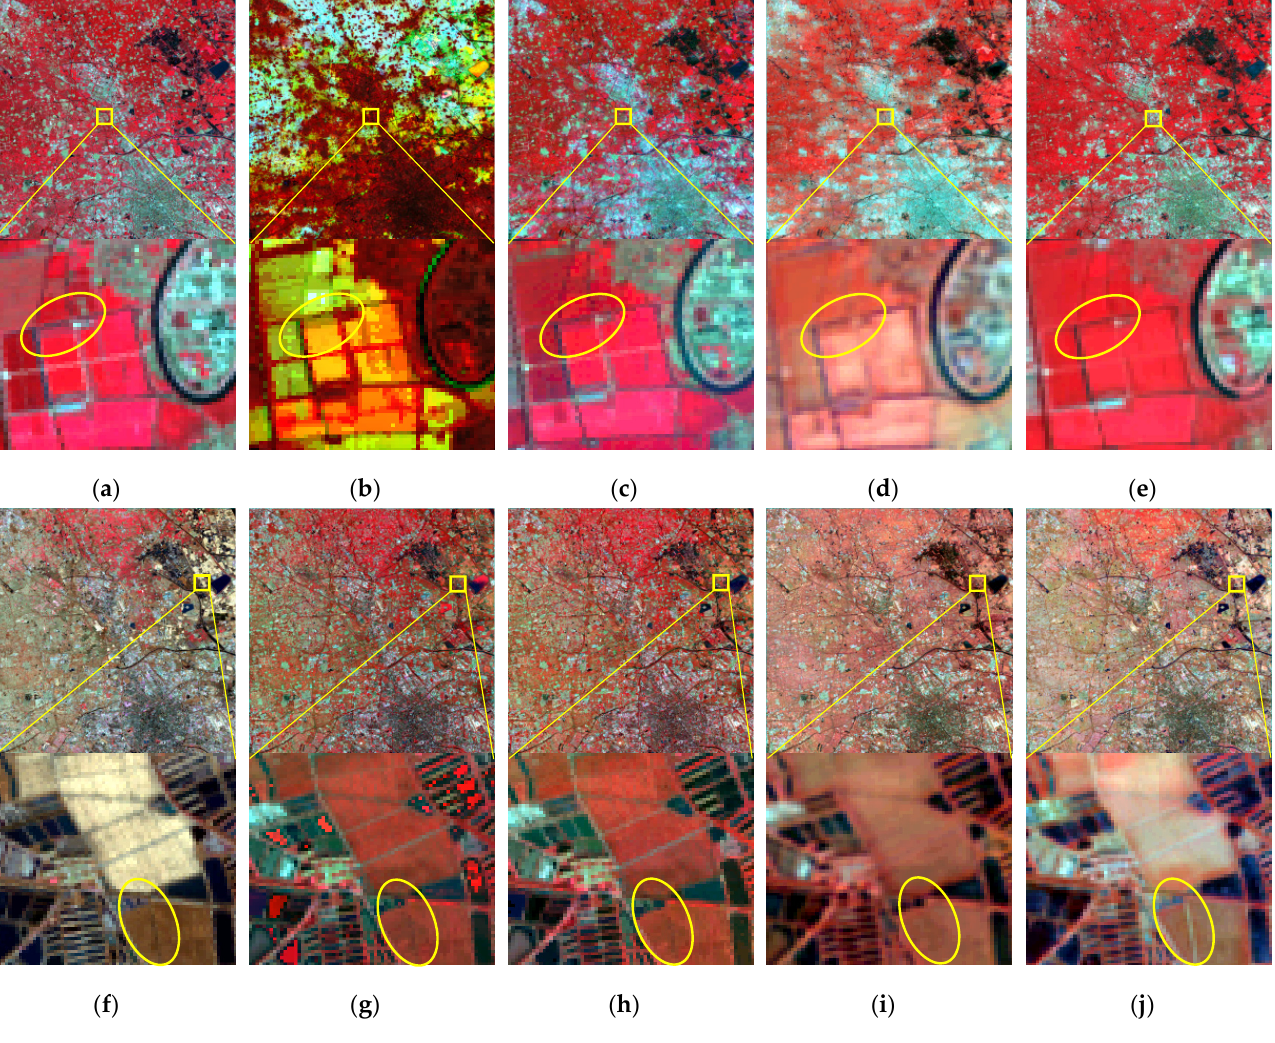
truth image; ( b , g ) STARFM method results; ( c , h ) FSDAF method results; ( d , i ) EDCSTFN method